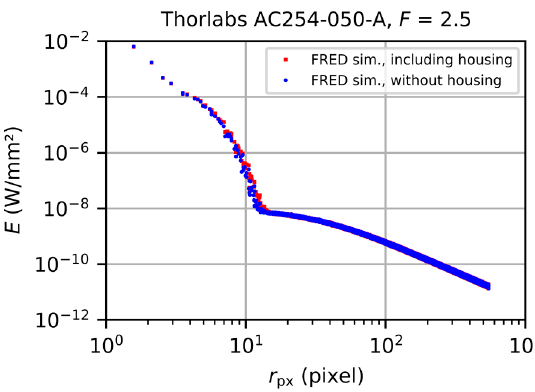
Figure 21. Simulated focal plane irradiance for the achromatic doublet lens. Red data points: simulation including housing. Blue data points: simulation without housing.